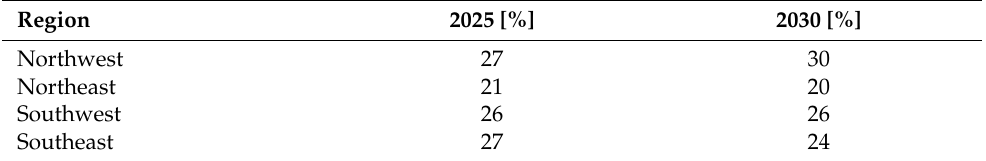
Table 2. Distribution of the installed Photovoltaic ( PV ) capacity amongst the four German regions.